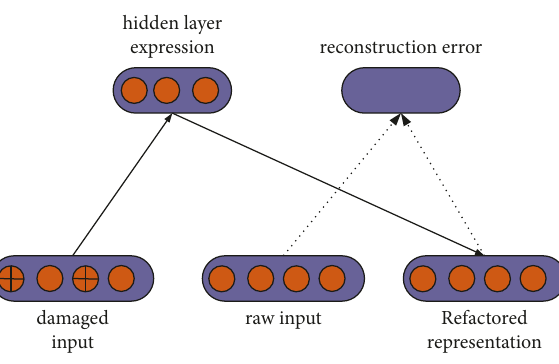
Figure 4: Sdae model